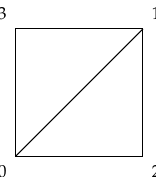
and π 2 for J 1 in Figure | J 1 | J 1